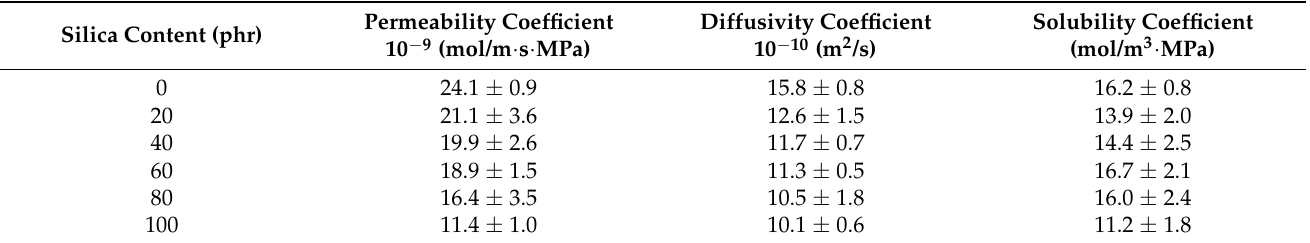
Figure 5. Hydrogen permeation properties of EPDM vulcanizates under 1 atm of hydrogen gas: ( a ) permeability coefficient, ( b ) diffusivity coefficient, and ( c ) solubility coefficient. Table 4. Summary of the hydrogen gas permeation parameters of the EPDM/silica vulcanizates. Permeability Silica Content (phr)